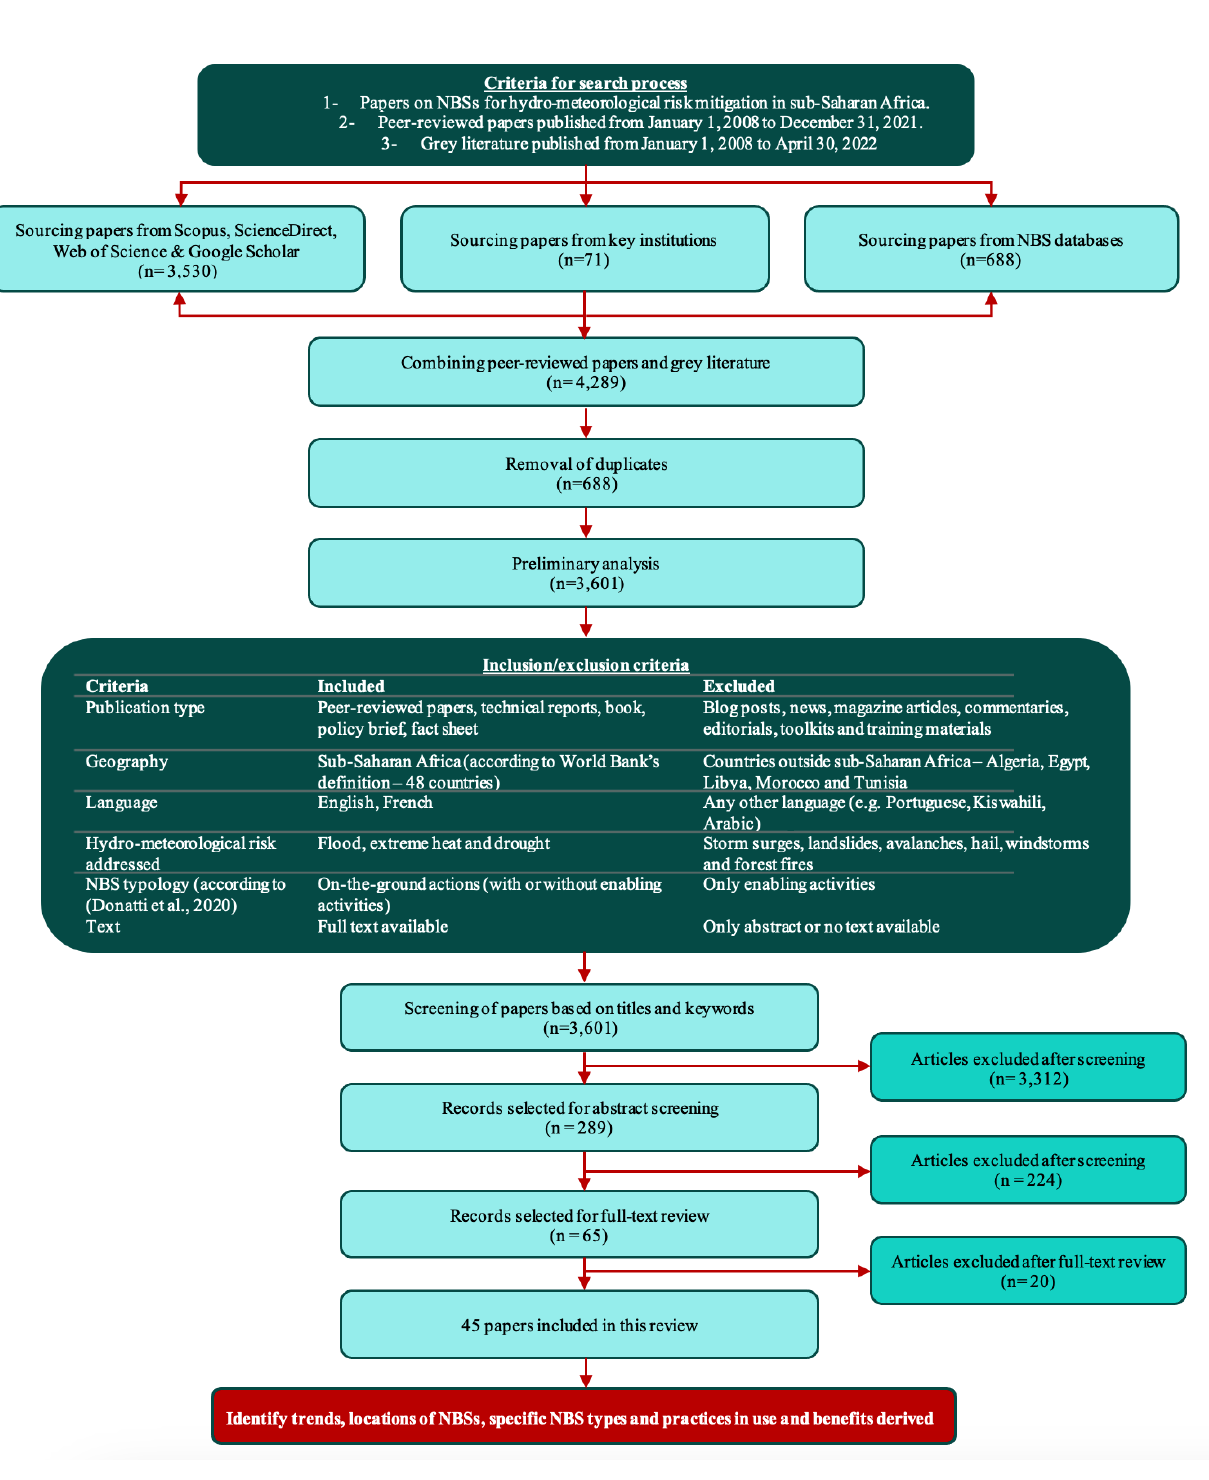
Figure 1. Flowchart of literature screening and selection